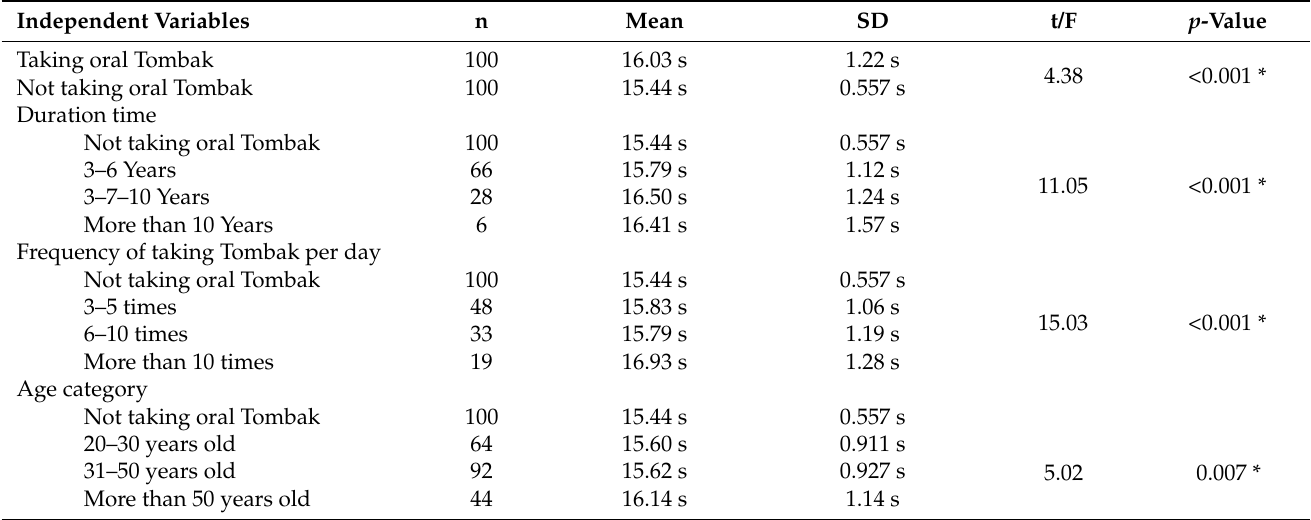
Table 2. The effects of taking oral Tombak on prothrombin time (PT) values among the study pop- ulation.